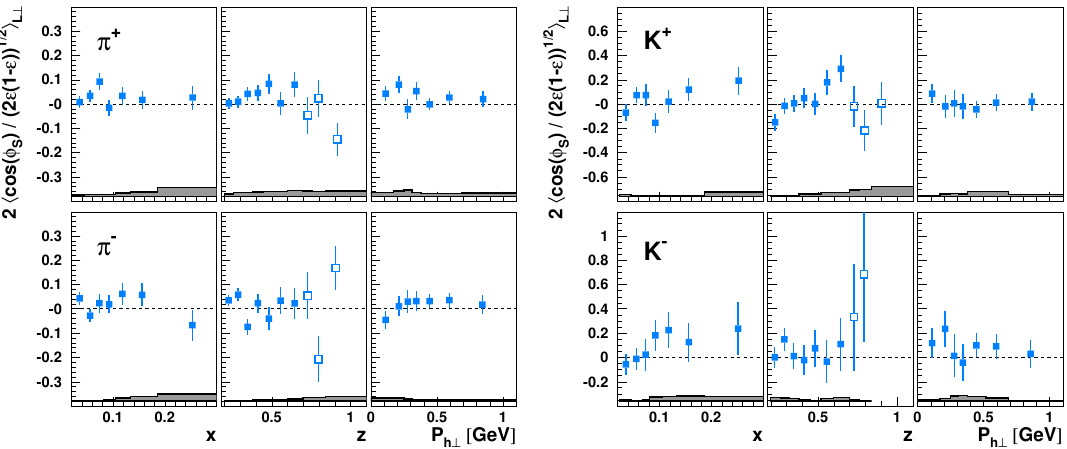
p Figure 31 . The 2 h cos( φ S ) / 2 (cid:15) (1 − (cid:15) ) i h amplitudes for charged mesons (left: pions; right: kaons) L ⊥ presented either in bins of x , z , or P h ⊥ . Data at large values of z , marked by open points in the z projection, are not included in the other projections. Systematic uncertainties are given as bands, not including the additional scale uncertainty of 8.0% due to the precision of the target-polarization determination.